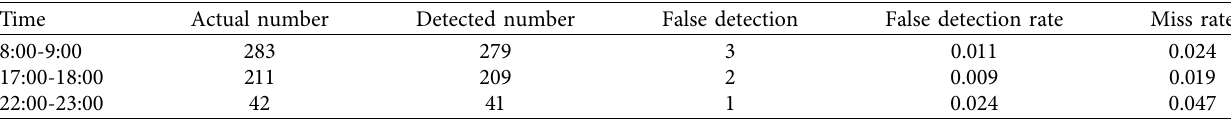
Table 6: Illegal parking detection results.